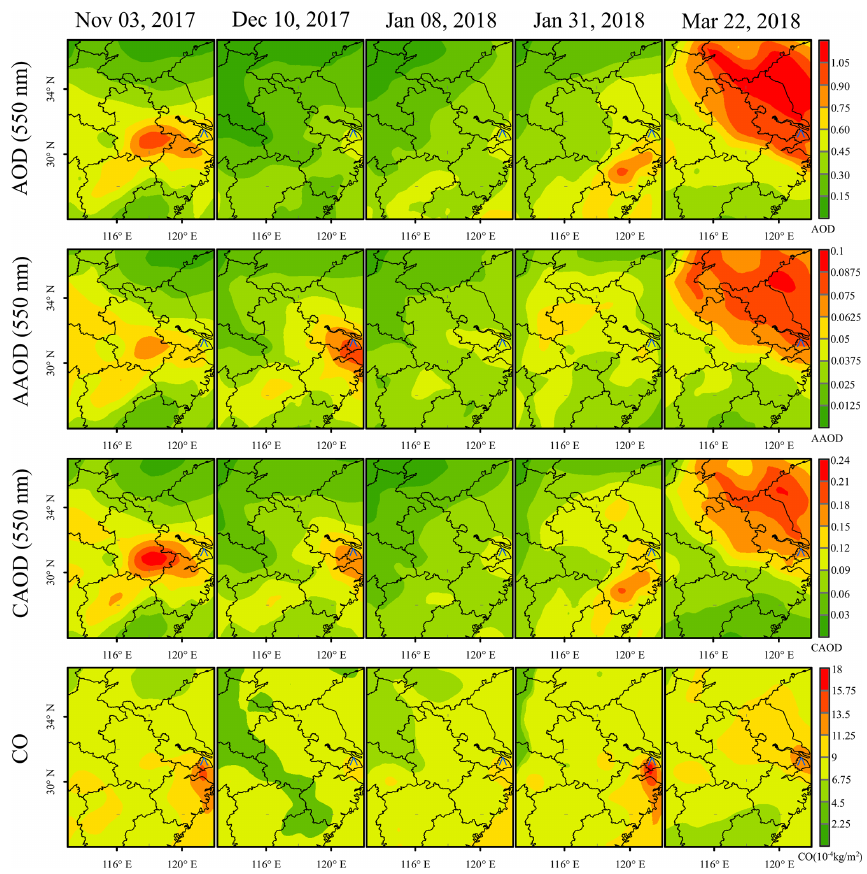
Figure 9. Spatial distribution of AOD, AAOD, CAOD, and CO column concentrations in five cases. From left to right, different cases are represented, and from top to bottom, different tracers are represented. The blue star is the location of the Raman lidar.